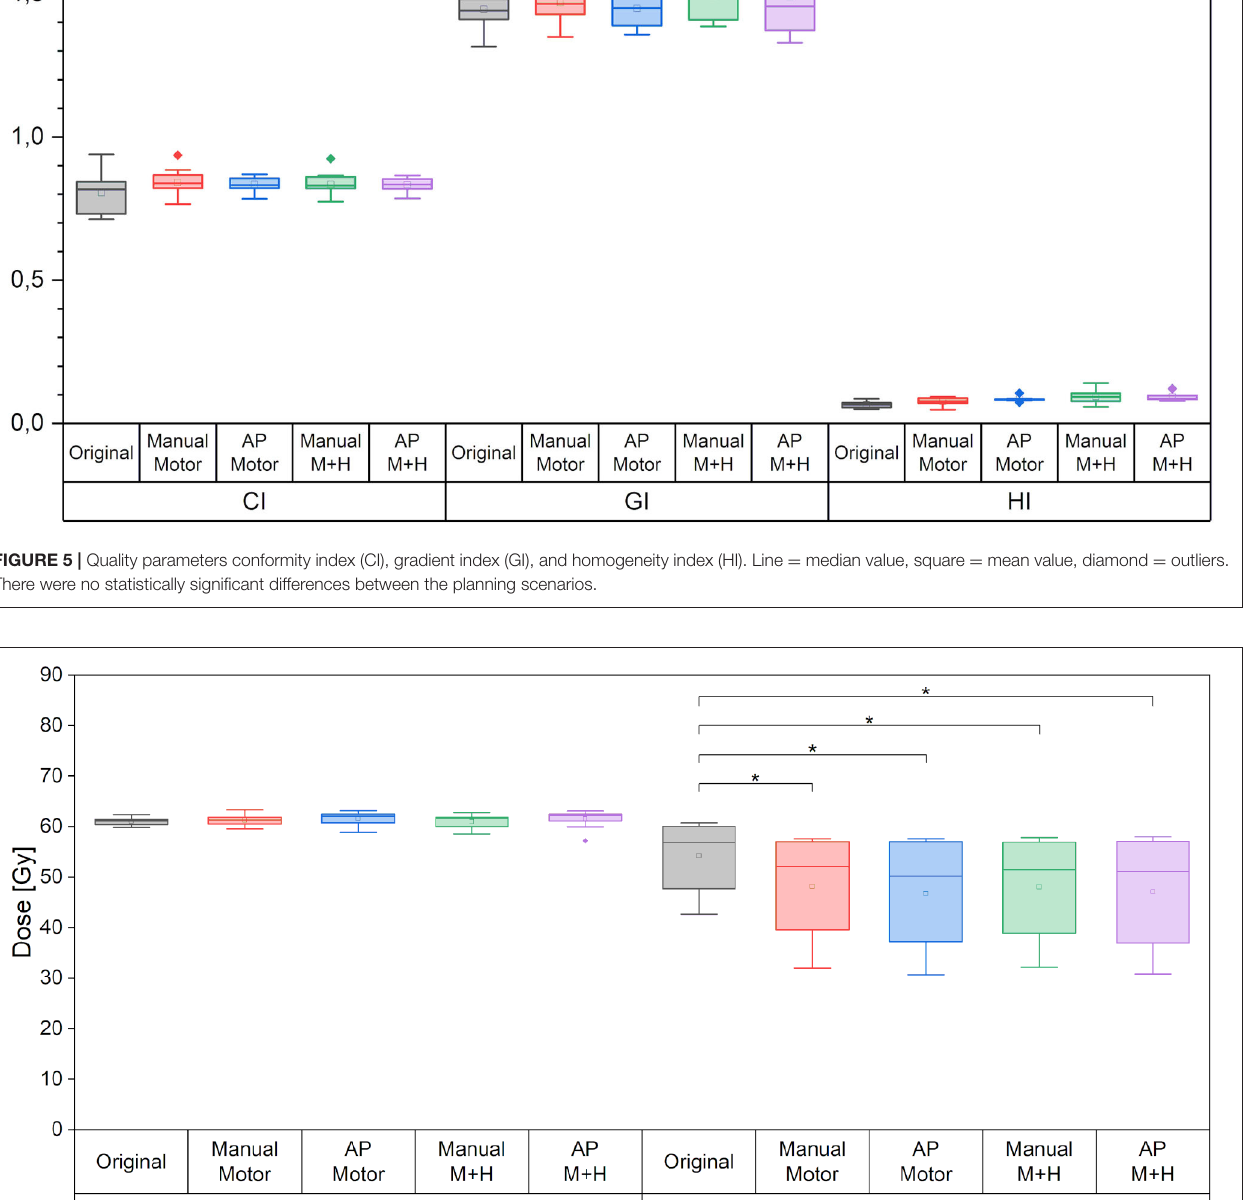
only motor sparing plans was not as large as the reduction of the motor and hippocampi sparing plans, which was statistically